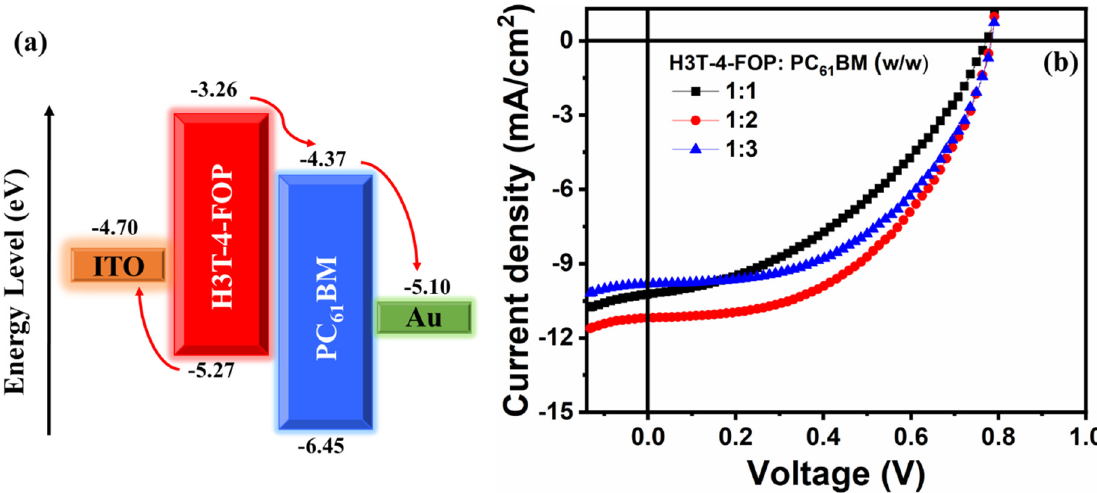
Figure 5. ( a ) Energy level diagram and ( b ) J-V curve of fabricated bulk heterojunction organic solar cells (BHJ-OSCs) with the active layer of H3T-4-FOP: PC 61 BM at various ratios (1:1 w/w, 1:2 w/w, and 1:3 w/w). Table 2. Photovoltaic parameters of the fabricated BHJ-OSCs devices with H3T-4-FOP:PC 61 BM active layer.